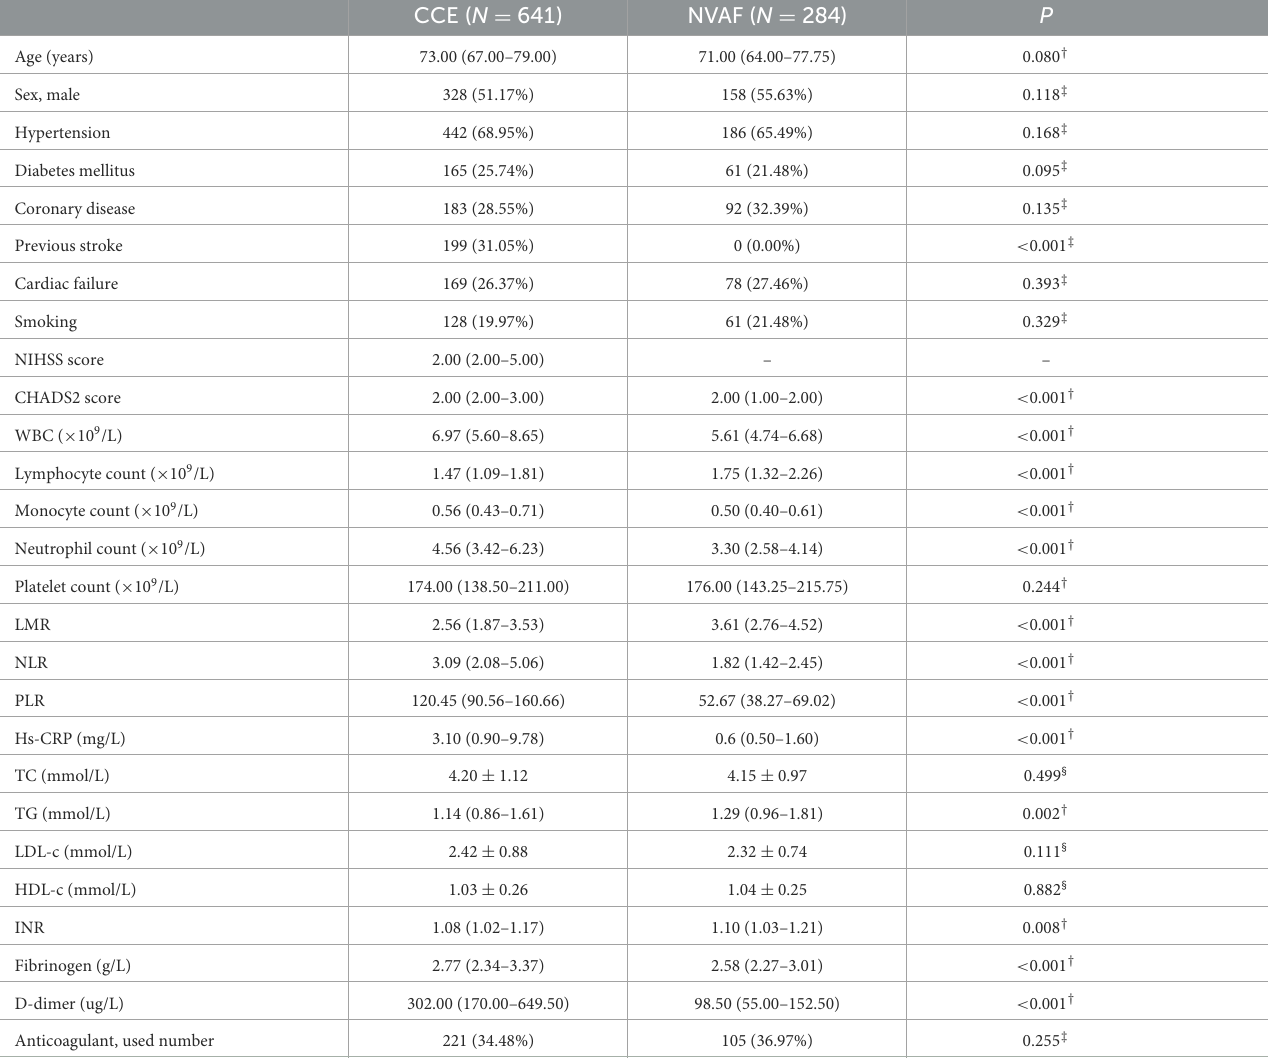
TABLE 1 Comparison of clinical characteristics between CCE patients with NVAF and single NVAF